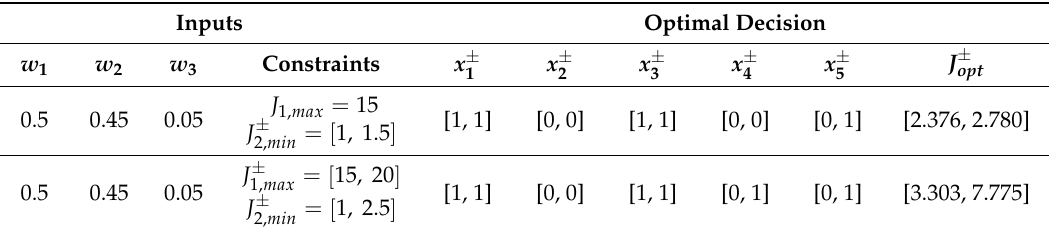
Table 4. Examples with uncertainty in the